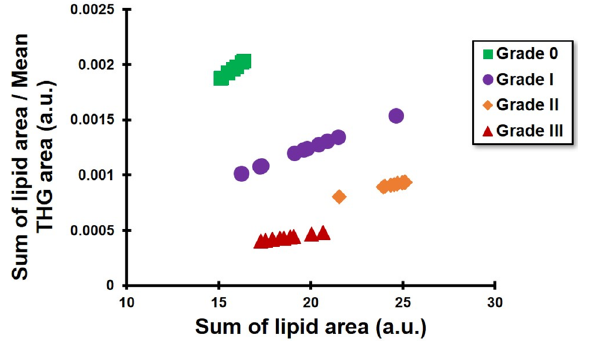
Figure 8. Scatter chart depicting sum of the lipid bond concentration divided with mean THG area of the corresponding breast tissues (y axis) as a function of the sum of lipid bond concentration (x axis). For this analysis N = 10 representative different tissue areas were